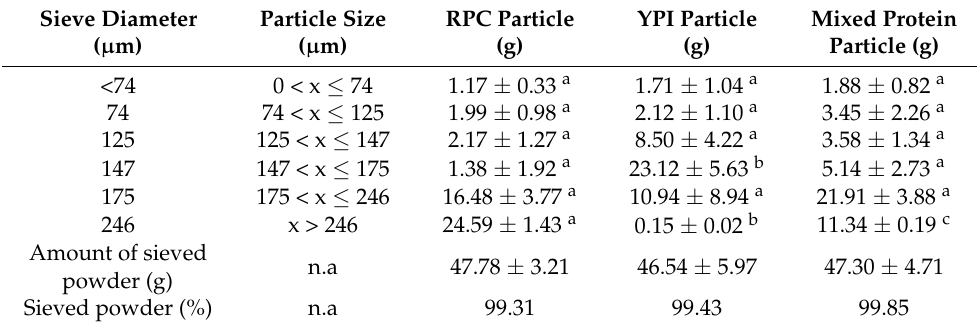
Table 3. Particle size measurement details of three different protein powder samples.